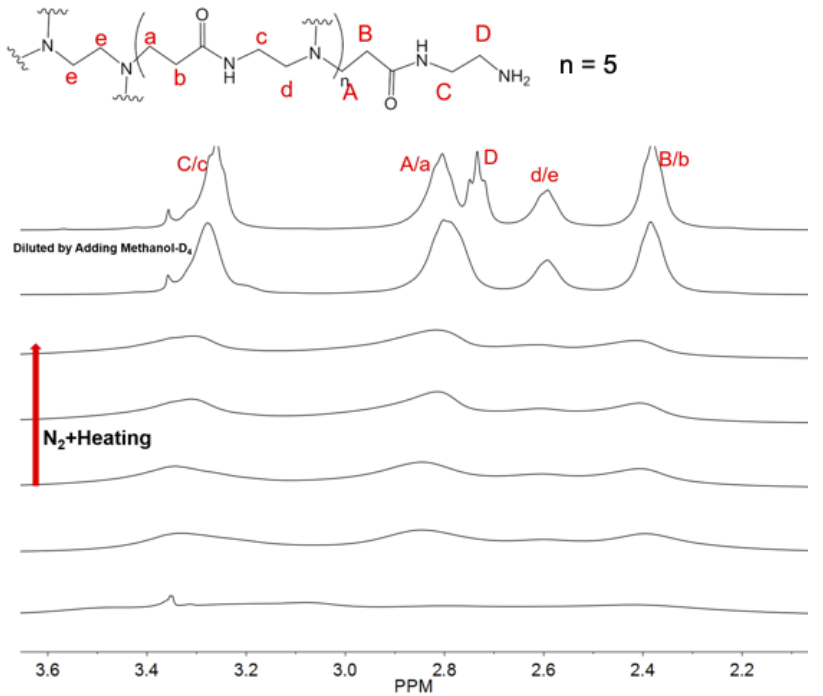
Figure 6. 1 H NMR spectra (400 MHz, CD 3 OD) of G5 dendrimer (0.02 M) upon addition of N 2 (g) to the solution under heating. The initial spectra (bottom) are extremely broadened due to gel formation. Addition of CD 3 OD at the end was necessary to replenish lost solvent due to